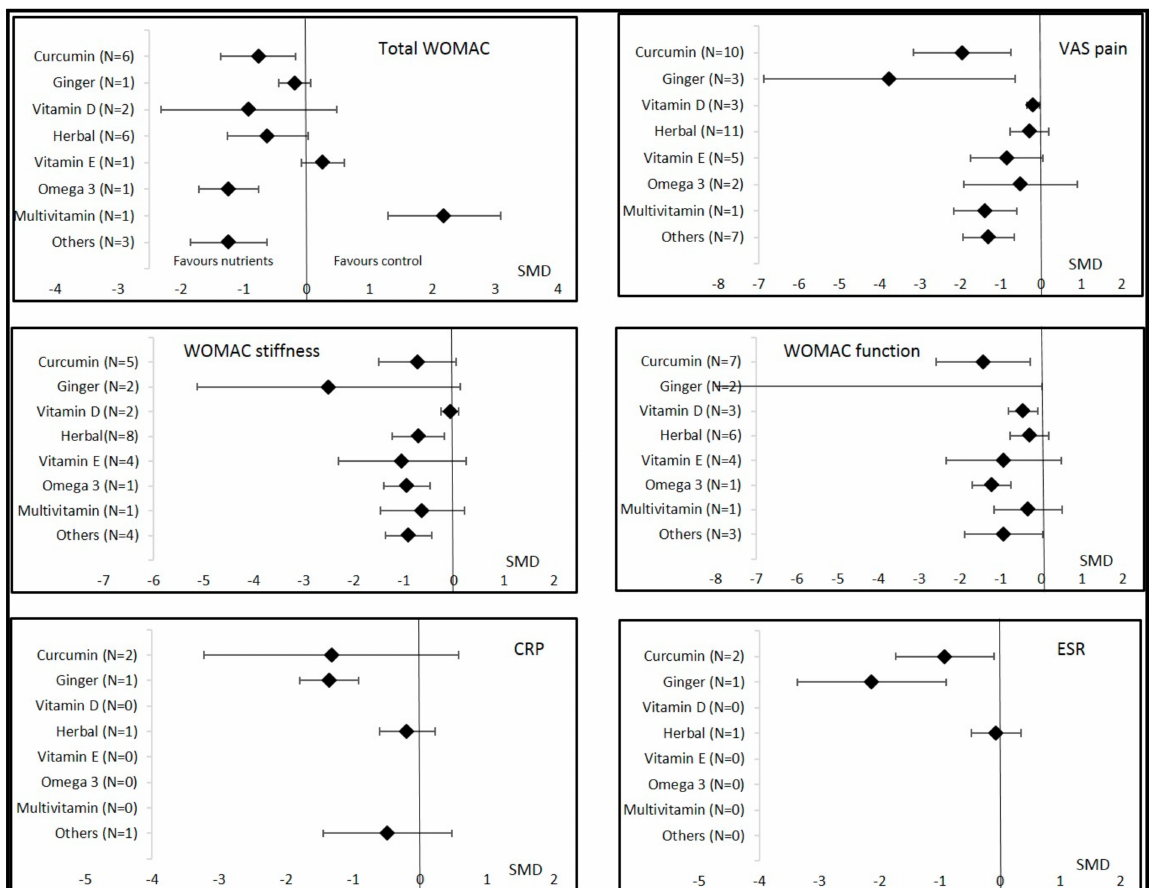
Figure 3. Overall effects of nutritional supplements in osteoarthritis patients compared to controls. Data are shown as the standardized mean differences (SMDs) and confidence intervals. VAS = visual analogic scale; CRP = C reactive protein; ESR = erythrocyte sedimentation rate; WOMAC = Western Ontario and McMaster Universities Osteoarthritis